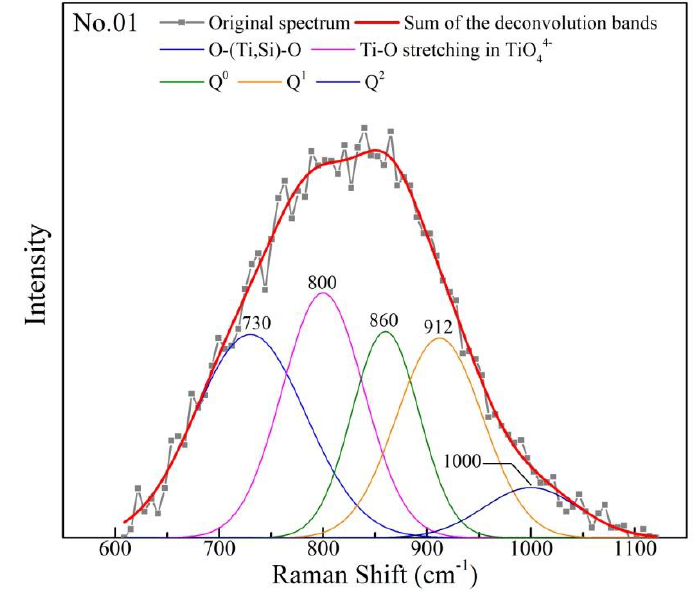
Figure 9. Typical set of Raman spectra deconvolution.